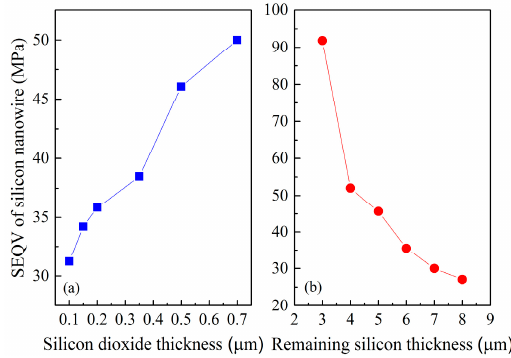
Figure 4. ANSYS simulation results: ( a ) SEQV of SiNW vs. silicon dioxide thickness; and ( b ) SEQV of SiNW vs. the remaining underlying silicon thickness.